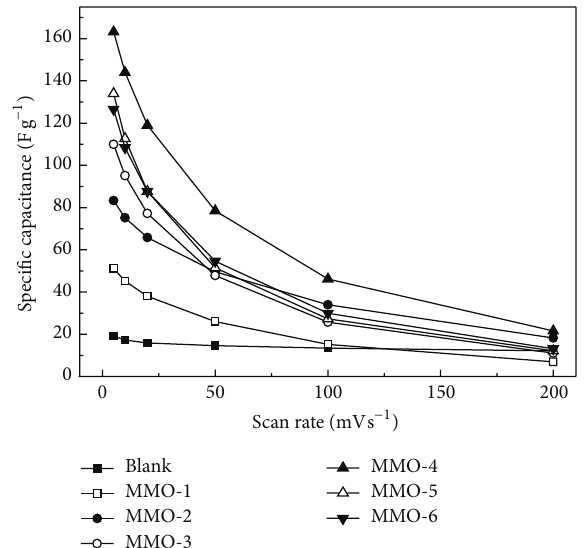
Figure 7: Specific capacitance of the samples of blank and MMO- 𝑥 ( 𝑥 = 1–6) at different scan rates.